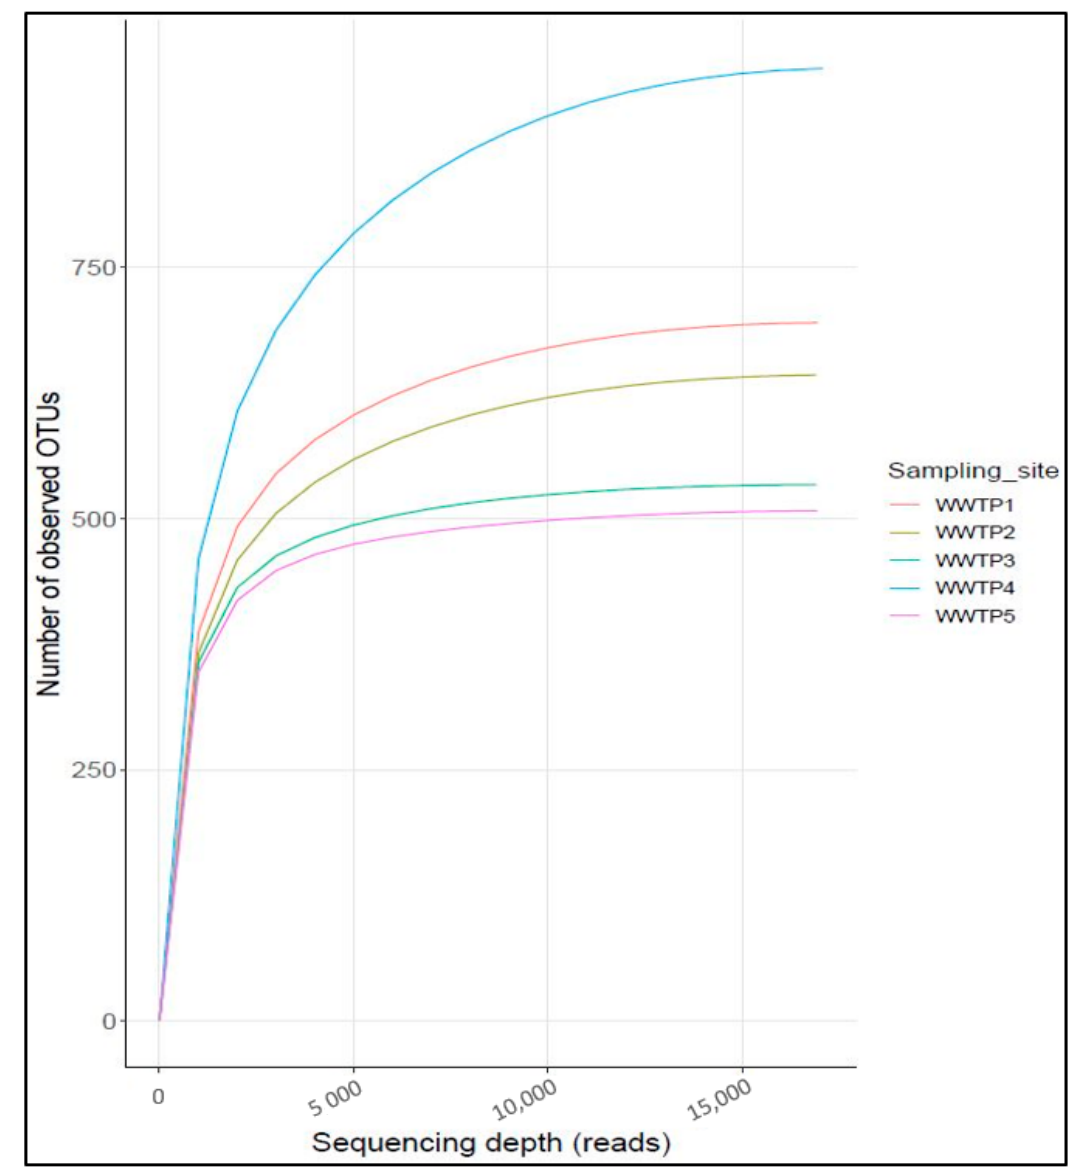
Figure 1. Rarefaction curves showing bacterial richness of influent wastewater from five WWTPs .